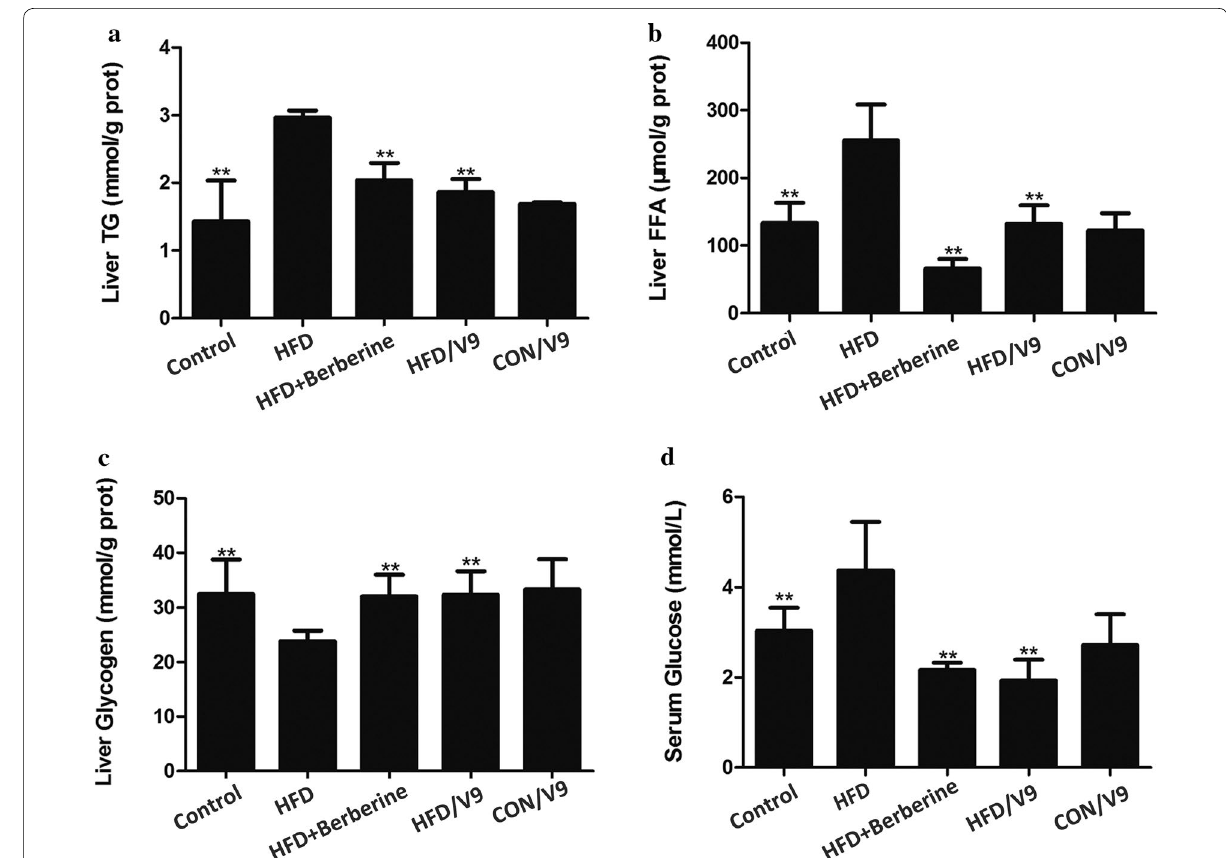
Fig. 2 V9 treatment improves HFD-induced metabolic disorder. a Hepatic levels of TG. b Hepatic levels of FFA. c Hepatic levels of Glycogen. d Fasting glucose levels in serum. Data are expressed as mean